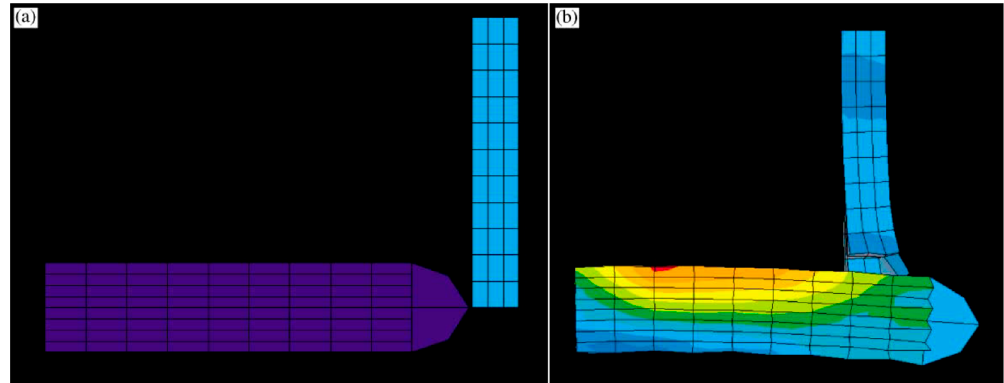
Figure 3. A simulation conducted by Chocron et al. [26]: ( a ) initial configuration; ( b ) 12 µs after impact showing bending and stress contours . Reprinted with permission from Elsevier: Int. J. Impact Eng. , Copyright 2021, License: 5017580939892.